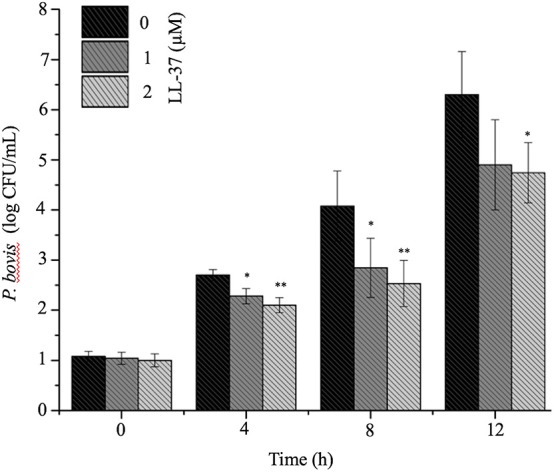
Synthetic human cathelicidin LL-37 inhibited in vitro Prototheca bovis. Prototheca bovis (1 × 105 CFU/mL in logarithmic growth phase) was incubated with synthetic human cathelicidin LL-37 peptides (up to 2 μM for up 12 h at 37°C) into Sabouraud dextrose broth and algae concentration were determined using a standard curve, with only P. bovis and expressed as log CFU/mL. Histogram of remaining P. bovis after peptide treatment. Data are shown as means ± SEM (n = 3 independent experiments done in triplicate). *p < 0.05, **p < 0.01 (one-way ANOVA post hoc Bonferroni correction) was considered significant.